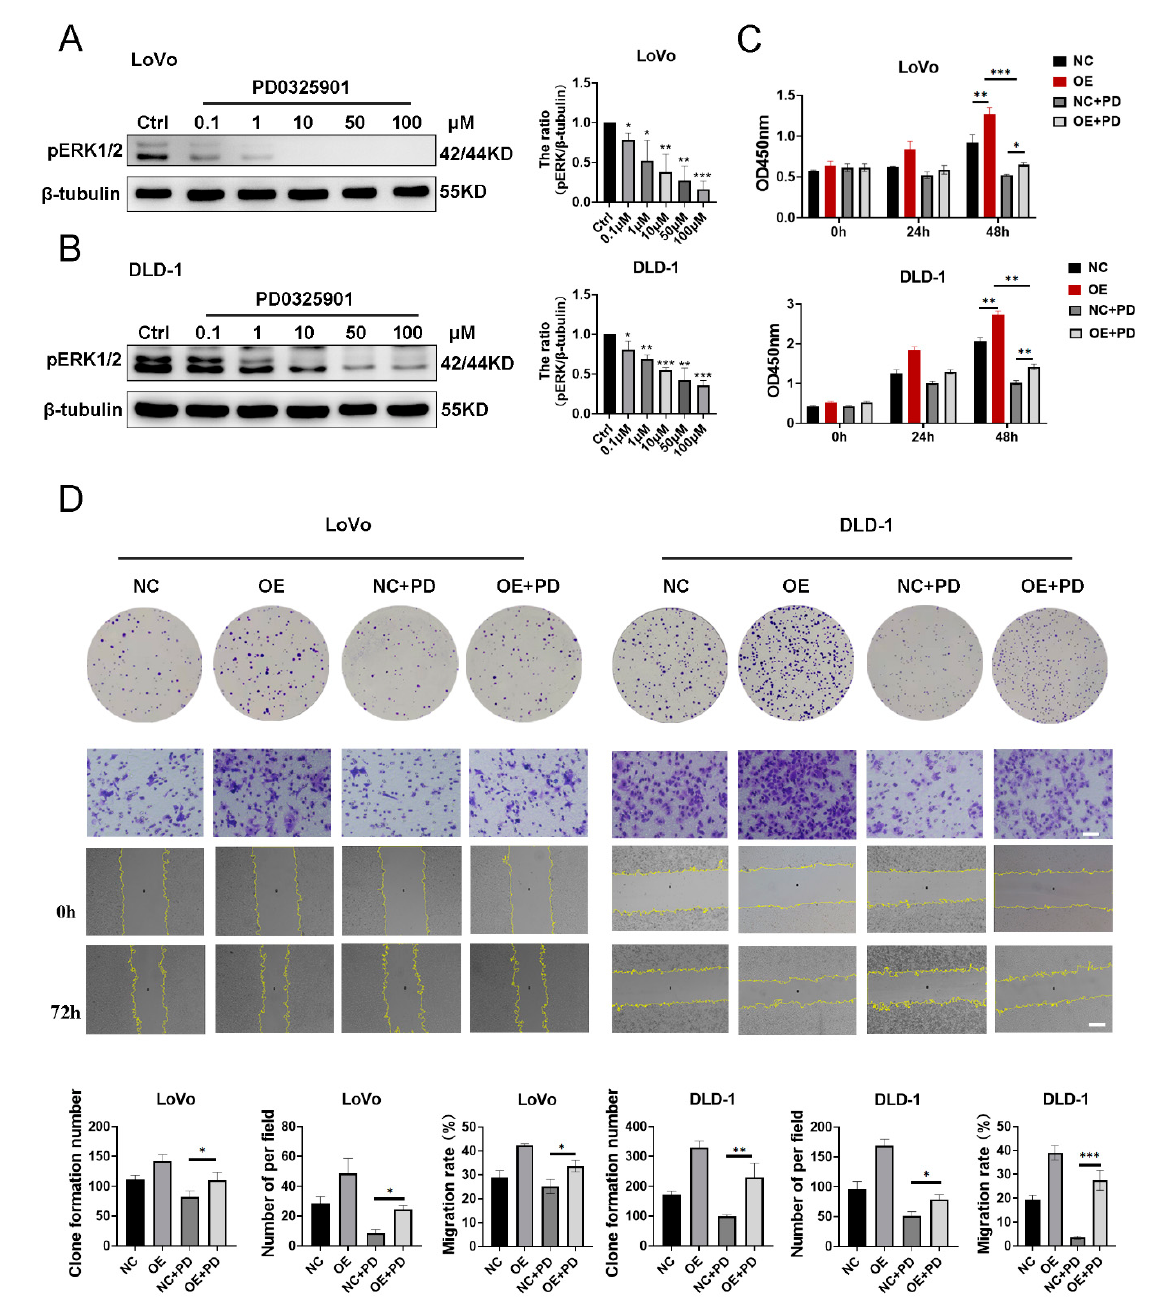
Figure 5. Overexpression of SUN5 partly attenuated the inhibition of proliferation and migration of CRC cells by PD0325901. ( A , B ) The Western blotting analysis of the pERK1/2 level in CRC cells treated with different concentrations of PD0325901 (0.1, 1, 10, 50, and 100 µ M) for 48 h. “Ctrl” indicates the control group with the added solvent (DMSO). ( C , D ) The cell proliferation and migration ability were evaluated by CCK8 (two-way ANOVA); colony-formation ( t -test) and Transwell ( t -test); and wound-healing assays (two-way ANOVA), respectively (* p < 0.05, ** p < 0.01, *** p < 0.001). Scale bar: 100 µ m (above), 200 µ m